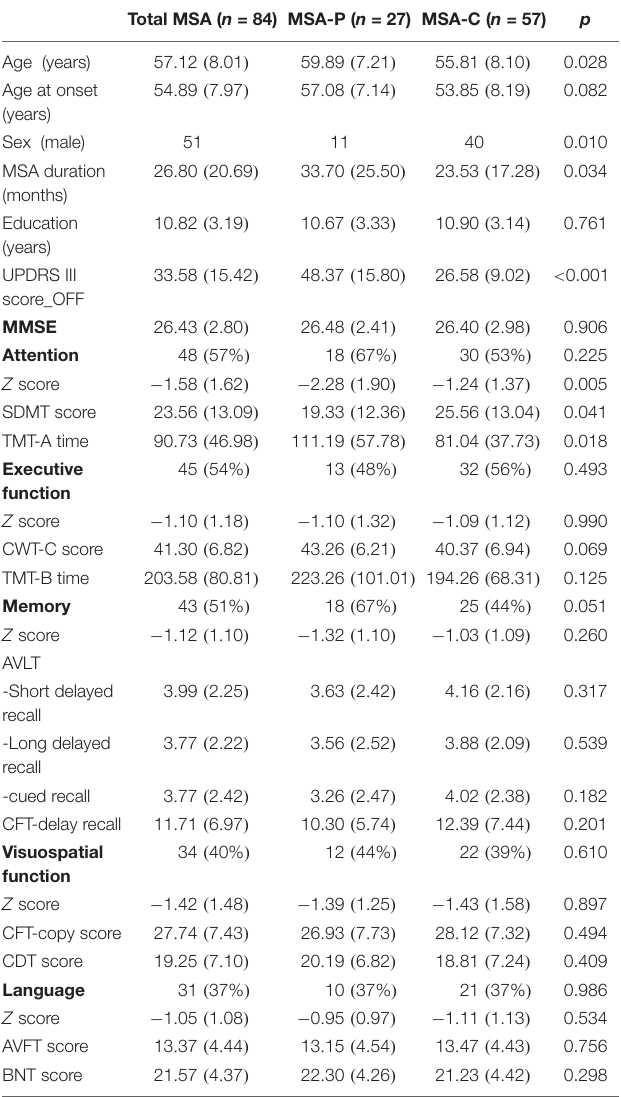
TABLE 1 | Demographic, clinical characteristics, and neuropsychological performance in 84 patients with multiple system atrophy